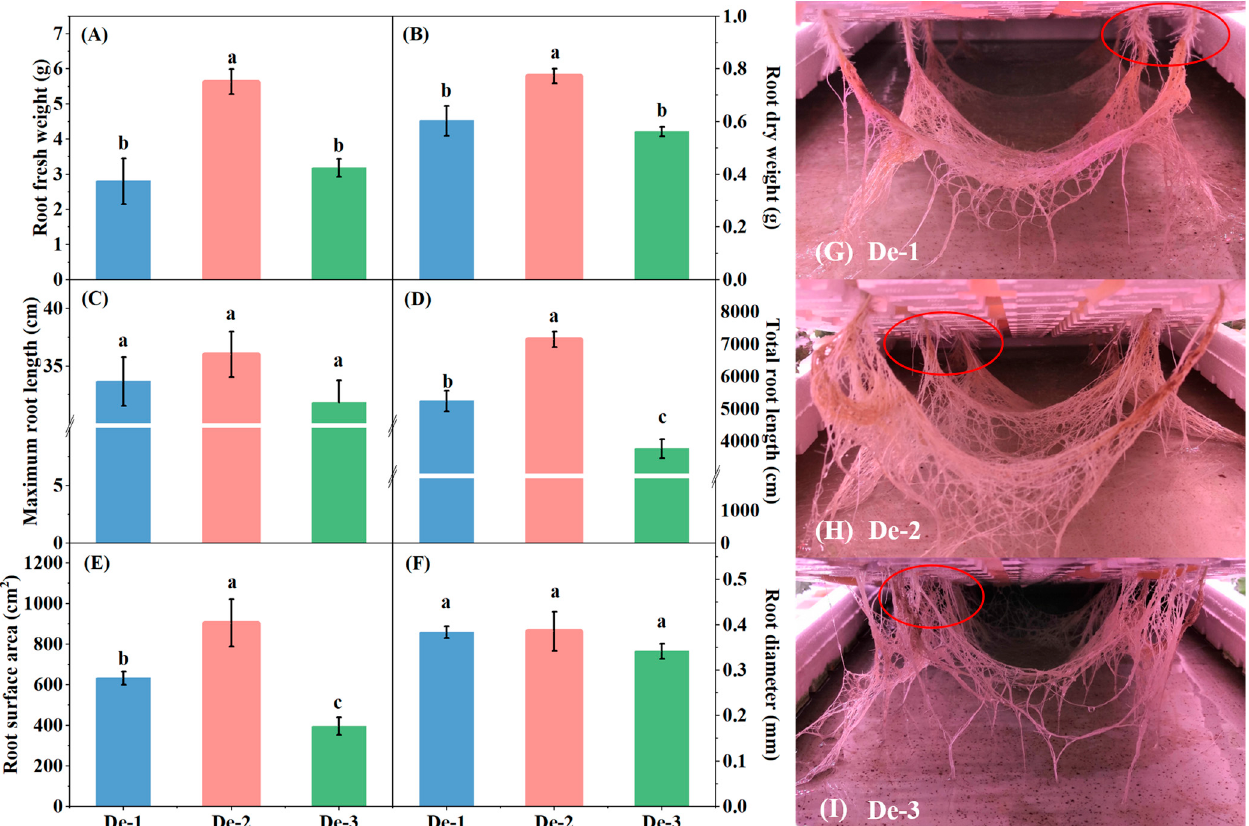
Figure 4. Root morphological properties of kale under different nutrient-solution depths as measured by ( A ) root fresh weight; ( B ) root dry weight; ( C ) maximum root length; ( D ) total root length; ( E ) root surface area; and ( F ) root diameter. Root morphology of kale 24 days after treatments: ( G ) De-1 treatment, ( H ) De-2 treatment, and ( I ) De-3 treatment. The red circles represent sprouting lateral roots in the air space. Different letters (a–c) marked upon the columns in the figure indicate significant differences between treatments by Duncan’s multiple ( p < 0.05), and vertical bars represent the standard margin of error.